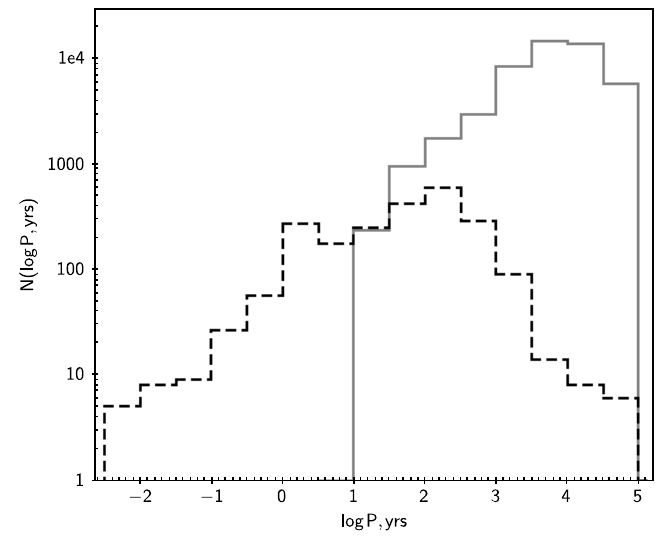
Fig. 3. Distribution of binaries over the period P : the solid line is for the refined WCT dataset and the dashed line, for all ORB6